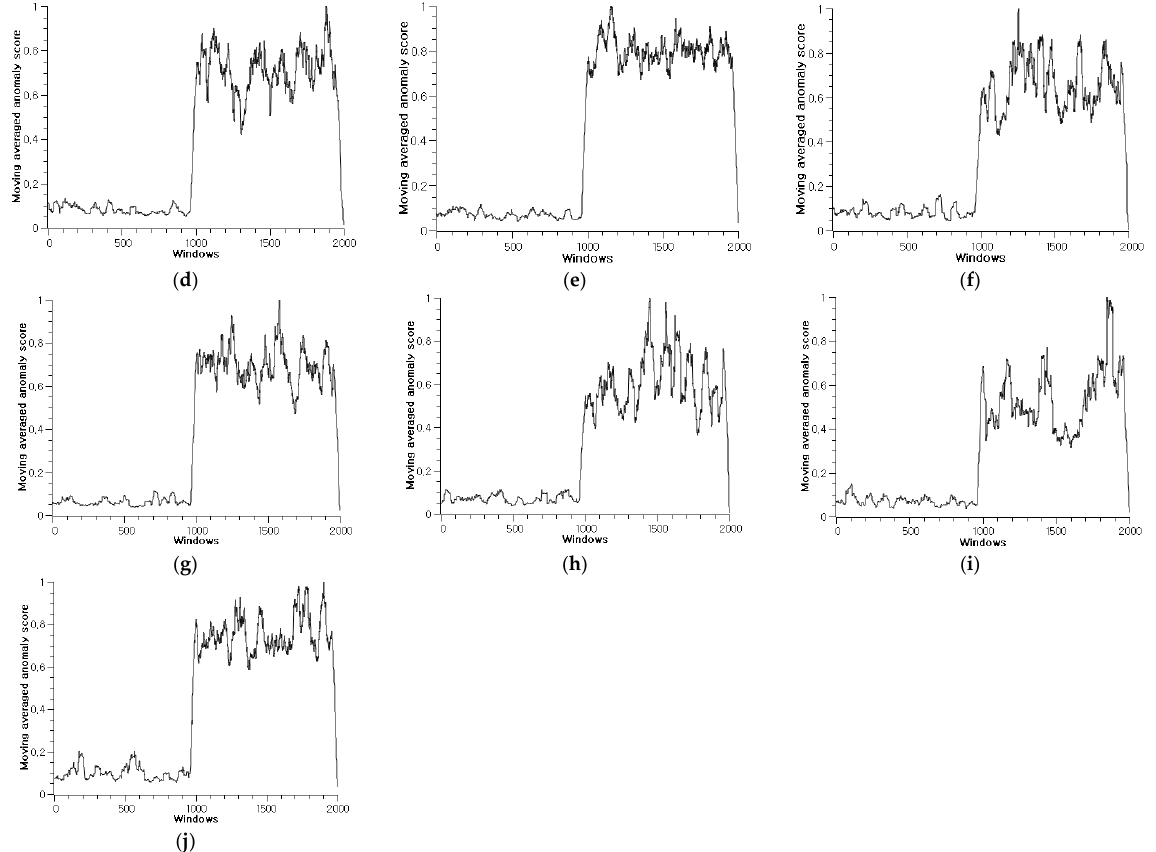
Figure 10. The moving-averaged anomaly score graphs of AAE with RaPP for scenarios 1–10: ( a ) Scenario 1; ( b ) Scenario 2; ( c ) Scenario 3; ( d ) Scenario 4; ( e ) Scenario 5; ( f ) Scenario 6; ( g ) Scenario 7;